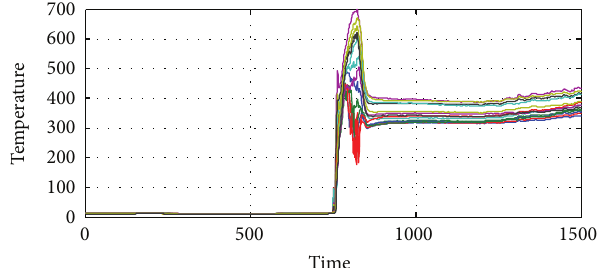
Figure 7: Exhaust temperatures from another set of thermometers.